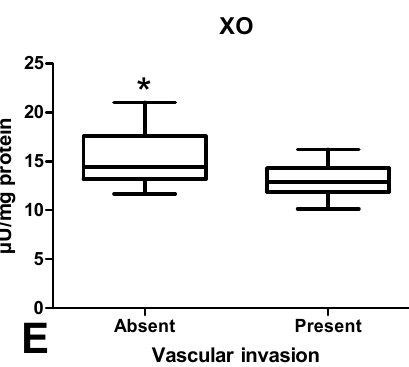
Figure 2. Comparison of: NOX ( A ) and XO ( B ) activity between colorectal cancer tissue ( n = 29) and normal mucosa ( n = 29); NOX activity ( C ) between adenocarcinoma and mucinous adenocarcinoma; XO activity ( D ) depending on the intensity of inflammatory infiltration in the invasive front of the tumour; XO activity ( E ) between colorectal tissue with and without vascular invasion. The data are presented as median (minimum–maximum). Abbreviations: NOX—NADPH oxidase, XO—xanthine oxidase. * p < 0.05, ** p < 0.01.